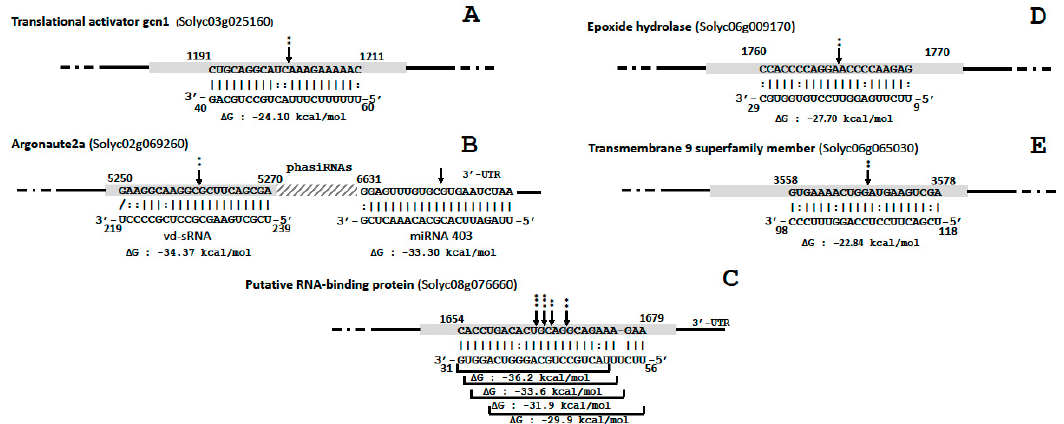
Figure 4. PTGS targets site of CEVd vd-sRNAs of the five genes highlighted in this study: ( A ) translational activator gcn1, ( B ) argonaute 2A, ( C ) putative RNA-binding protein, ( D ) epoxide hydrolase and ( E ) putative RNA-binding protein The arrows indicate the predicted RISC mediated cleavage sites with their respective probability computed according to Poisson’s regression of normalized counts of 5 ′ RNA ends (* P ≤ 0.05; ** P ≤ 0.01; *** P ≤ 0.001). Complementarity between nucleotide pairs was depicted as follows: | for Watson-Crick base pairs, / for wobble base pairs and: for mismatches. Coding regions of genes are depicted as gray rectangles; intron and 3 ′ -UTR are represented as black lines. The sequences are shown in the complementary polarity. The PairFold online tool was used to predict the minimum free energy ( Δ G) of RNA duplexes.